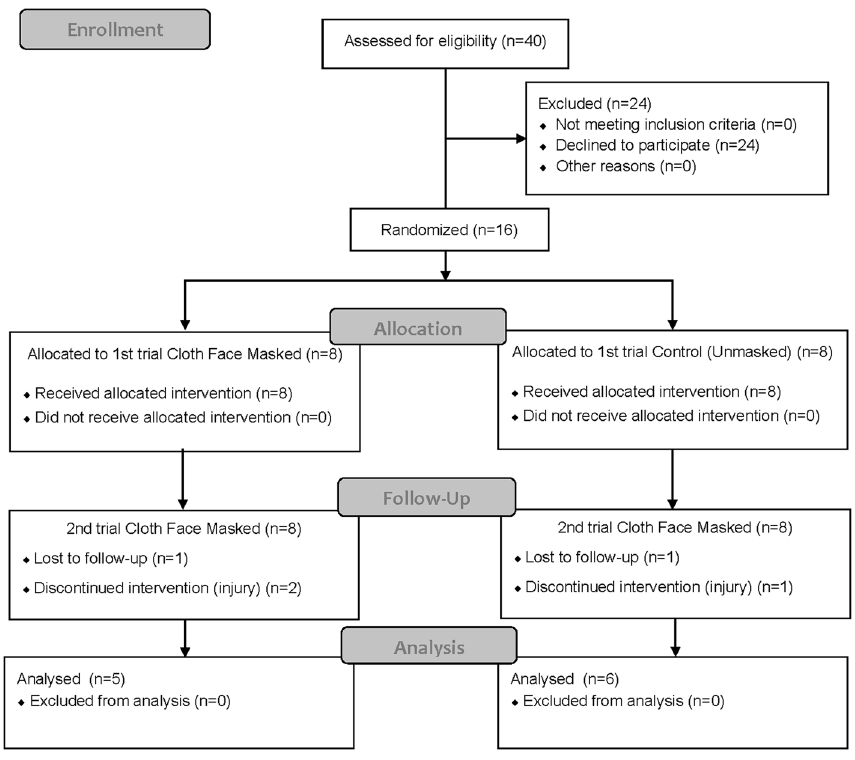
Figure 1. CONSORT flow diagram. The diagram indicates how many individuals were screened and completed under two condition trials.